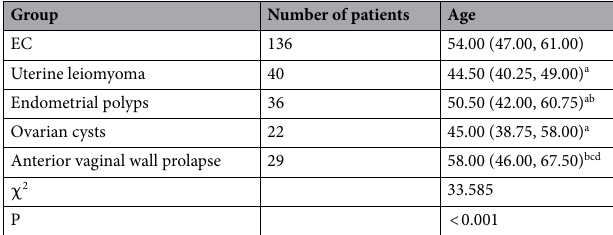
Table 1. General data (mean (Q25, Q75). EC endometrial cancer. a A significant difference compared with the EC group. b a significant difference compared with the uterine leiomyoma group. c a significant difference compared with the endometrial polyp group. d a significant difference compared with the ovarian cyst group.